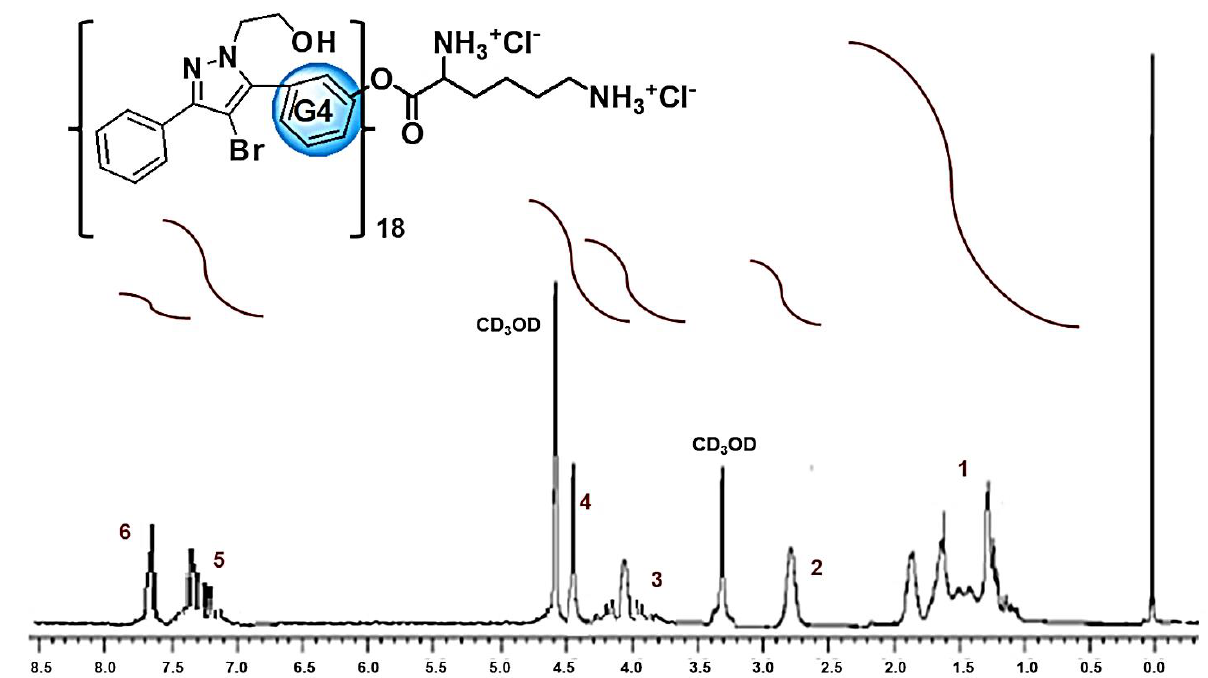
Figure 7. 1 H NMR spectra (CD 3 OD, 400 MHz) of BBB4-G4K, also reporting the integrals belonging to all the signals or groups of signals of the spectrum (dark red curves). Signals attribution: 1 = 423 H (CH 3 of G4K + CH 2 CH 2 CH 2 of lys), 2 = 96 H (CH 2 NH 3+ of lys), 3 = 120H (CH 2 of BBB4 + CHNH 3+ of lys + CH 2 of BBB4), 4 = 186 H (CH 2 O of G4K), 5 = 144 H (CH= of phenyl rings), 6 = 36 H (CH= of phenyl rings).